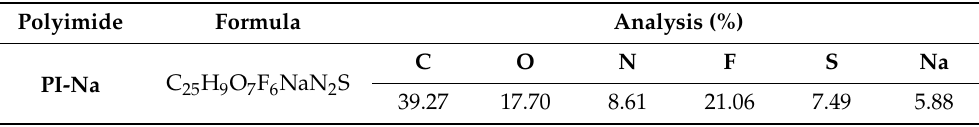
Figure 3. Electron-microscope images taken at different locations of the polyimide-material surface: center, 750× ( left ) and edge, 5000× ( right ). Table 2. Data quantitative X-ray microanalysis for the surface of PI-Na-based material obtained using REM.